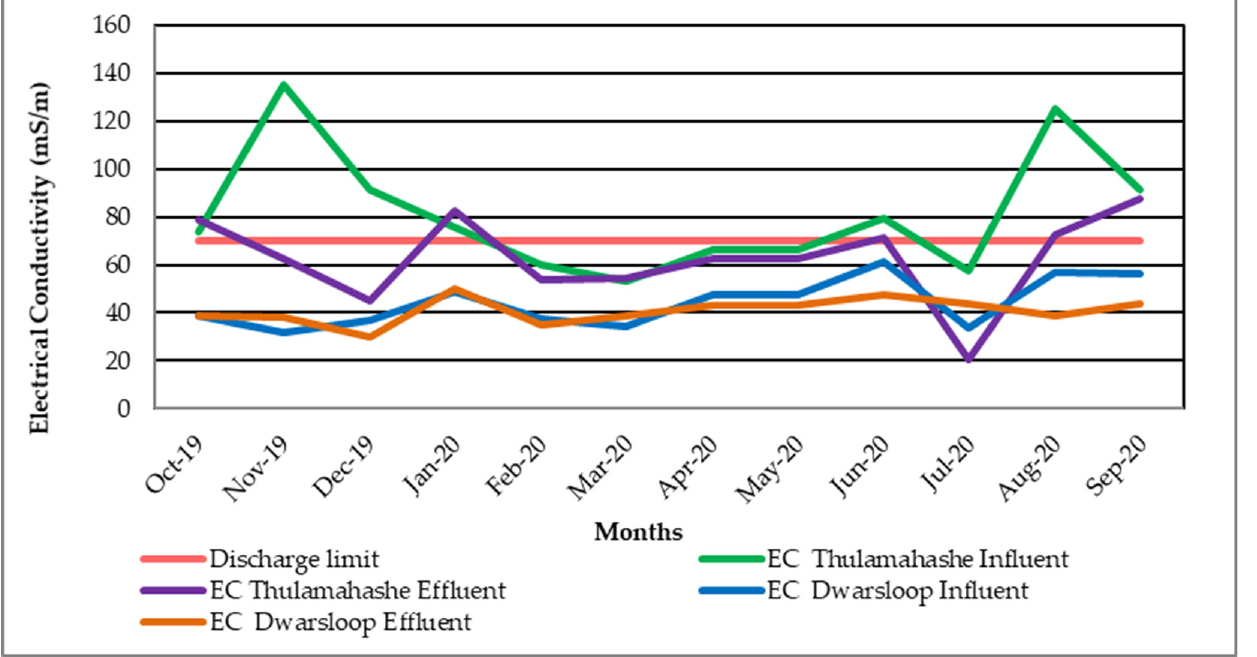
Figure 6. WWTWs performance in terms of electrical conductivity. Figure 7 depicts the average concentrations of suspended solids in the influent and effluent of Thulamahashe WWTW, which ranged from 37.60 to 326.00 mg/L and 2.00 to 93.60 mg/L, respectively, while at the Dwarsloop WWTW, the concentrations ranged from 18.00 to 797.00 mg/L and 2.00 to 21.50 mg/L. The Thulamahashe WWTW had